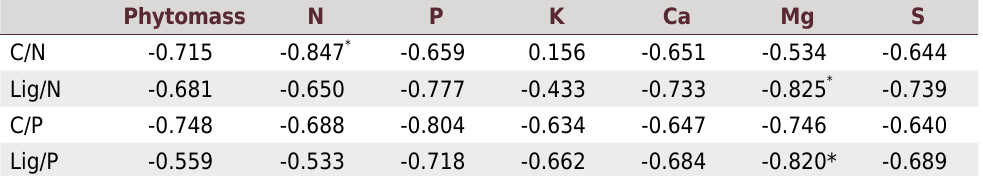
Table 3. Pearson’s correlation coefficient between decomposition or nutrient release constant ( k ) and carbon/nitrogen (C/N), lignin/nitrogen (Lig/N), carbon/phosphorus (C/P), and lignin/phosphorus (Lig/P) ratios of the shoot phytomass from different cover